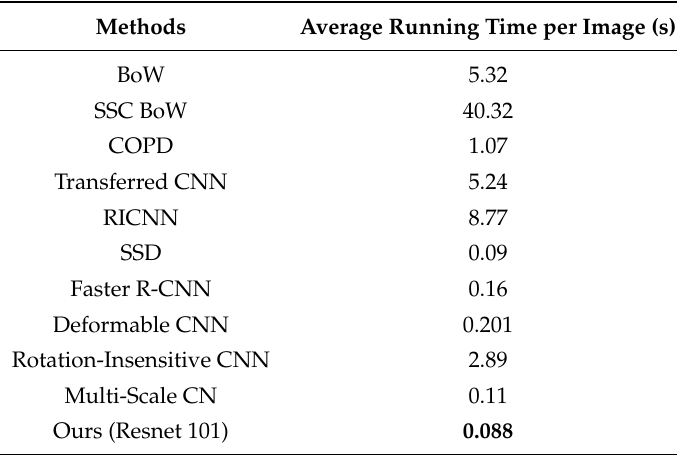
Table 3. Computation time comparison of different models.